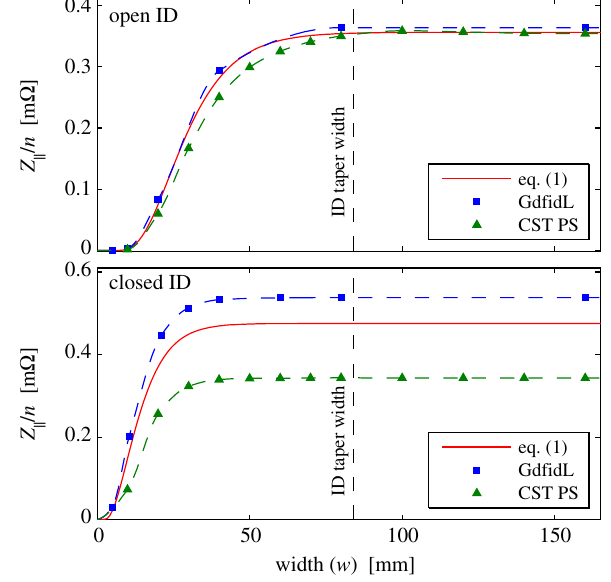
FIG. 4. Longitudinal normalized impedance — width depend- ence calculated for b ¼ 15 mm (upper plot) and for b ¼ 2 . 5 mm (lower